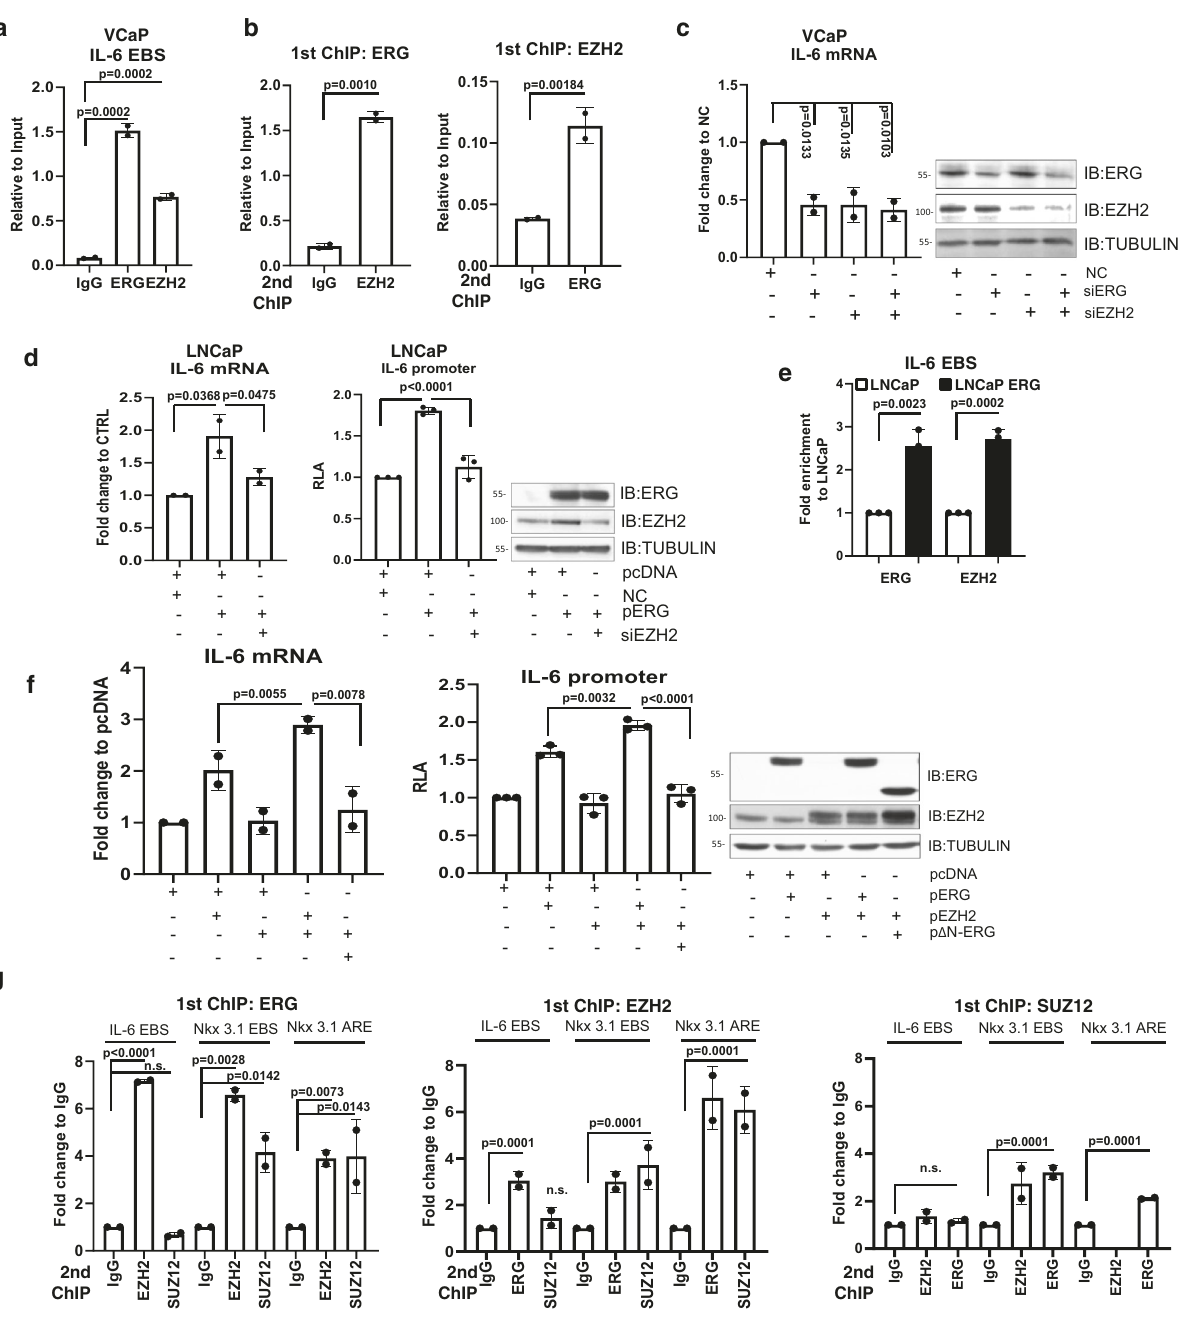
Fig. 4 ERG and EZH2 co-occupy gene promoters forming activatory and repressory complexes. a ChIP analysis of ERG and EZH2 occupancy on the IL-6 promoter in VCaP cells. Data are presented as fold enrichment relative to input. b ChIP – reChIP analysis of ERG and EZH2 to evaluate co-occupancy at the IL-6 promoter in VCaP cells. Data are presented as fold enrichment relative to input. c qRT-PCR analysis of IL-6 mRNA and immunoblotting analysis of the indicated proteins (right) upon ERG and EZH2 knockdown in VCaP cells. d qRT-PCR analysis of IL-6 mRNA (left) and IL-6 promoter activity by luciferase reporter assay (middle) in LNCaP cells with ERG overexpression and EZH2 knockdown. Expression of the indicated proteins was veri fi ed by immunoblotting (right panel). e ChIP analysis of ERG and EZH2 occupancy in the IL-6 promoter at the ETS binding site (EBS) in LNCaP and LNCaP-ERG stable cell lines. f IL-6 mRNA determined by qRT-PCR (left) and IL-6 promoter activity by luciferase reporter assay (middle) in LNCaP transfected with the indicated plasmids. Expression of the indicated proteins was veri fi ed by immunoblotting (right). g ChIP – reChIP analysis of EZH2, ERG, and SUZ12 to evaluate co-occupancy at the IL-6 and Nkx3.1 promoters in VCaP cells. Data are presented as fold enrichment relative to IgG of the Re-ChIP. All error bars, mean ± s.d. ( n = 3, technical replicates). P -values were determined by one-way ANOVA test. Source data are provided as a Source Data